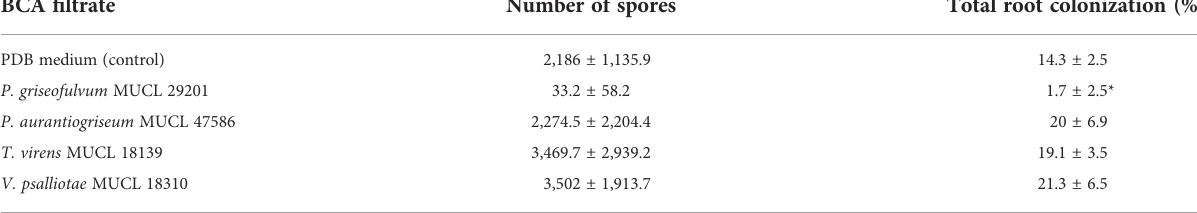
The values are expressed as the mean ± SD (n = 5). In a column, the asterisks show a signi fi cant difference with the control (p ≤ 0.05; Dunnett ’ s HSD). Measurements were made 12 weeks after association.